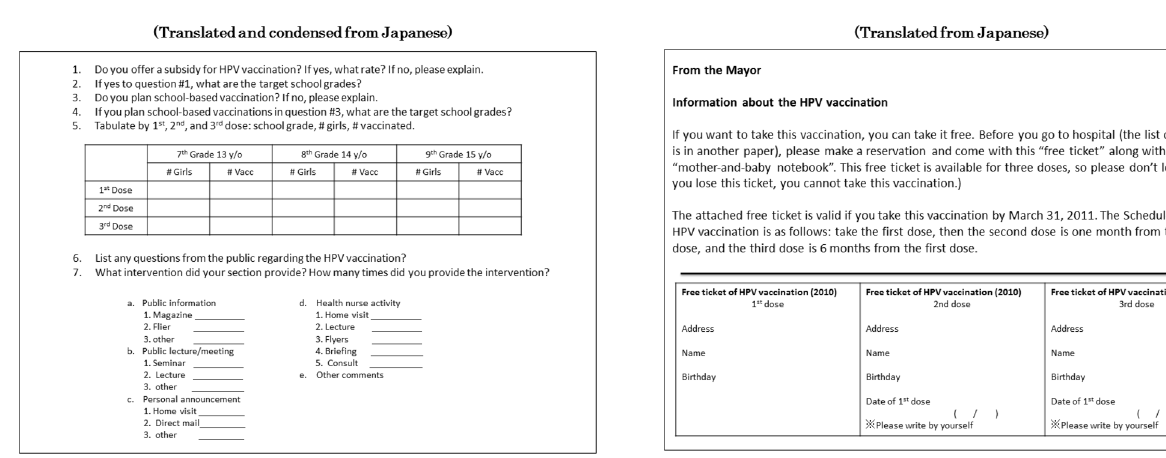
Figure 1. HPV Vaccination Survey. The HPV Vaccination Survey was sent to all 27 local government entities (cities and towns) in Tochigi prefecture, Japan in October 2010 requesting data for April through December 2010. Complete responses were received from 22 local governments. Supplementary data was obtained by follow-up telephone